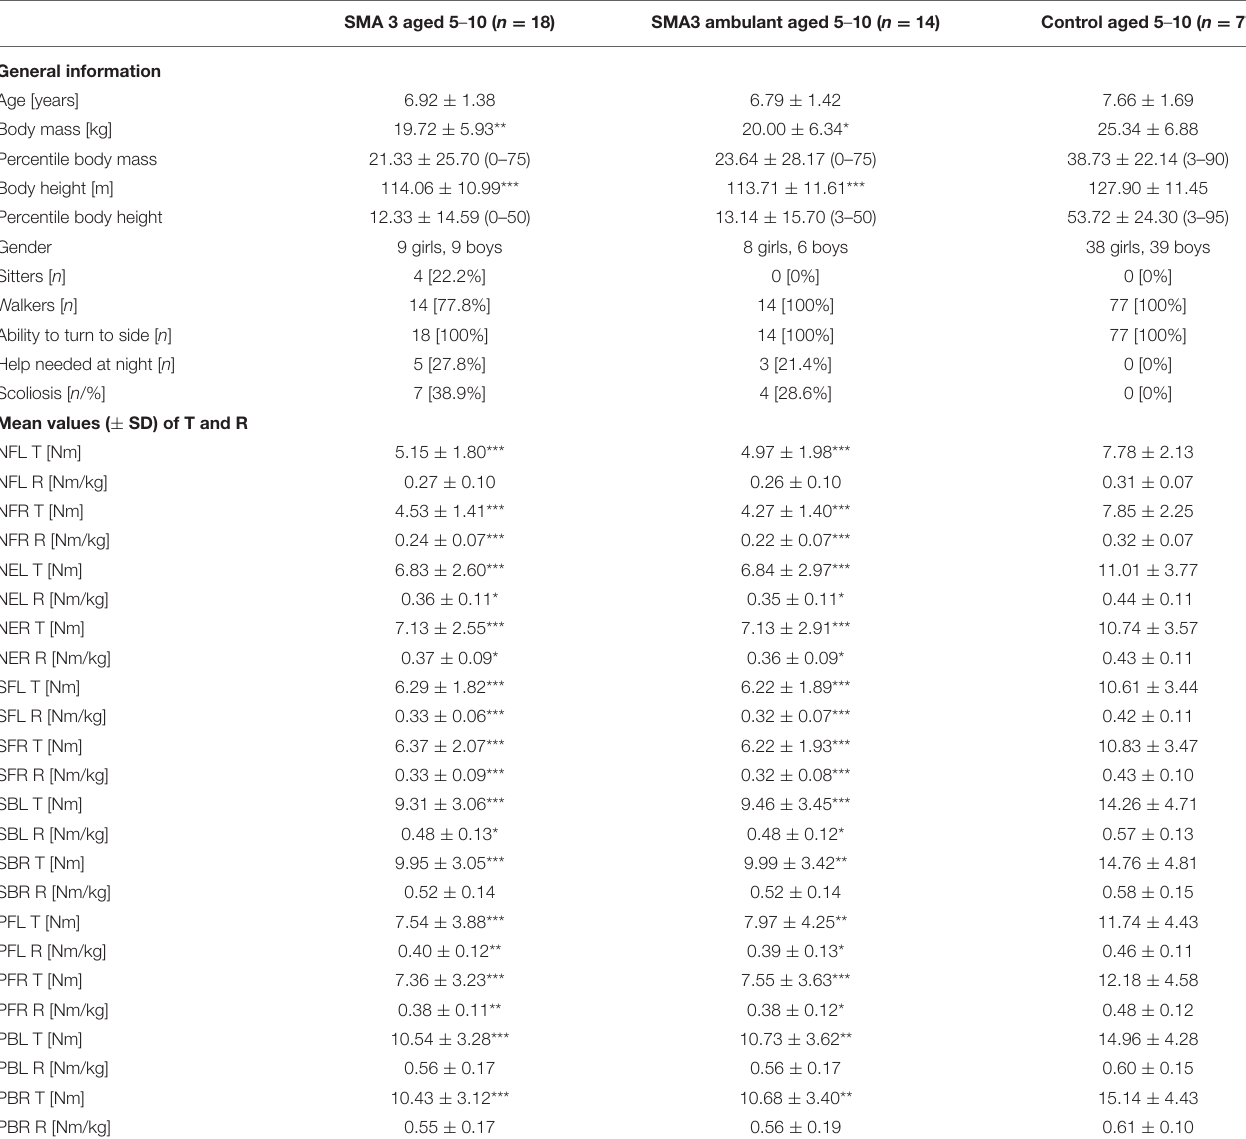
TABLE 4 | Characteristic of SMA3 and healthy participants aged